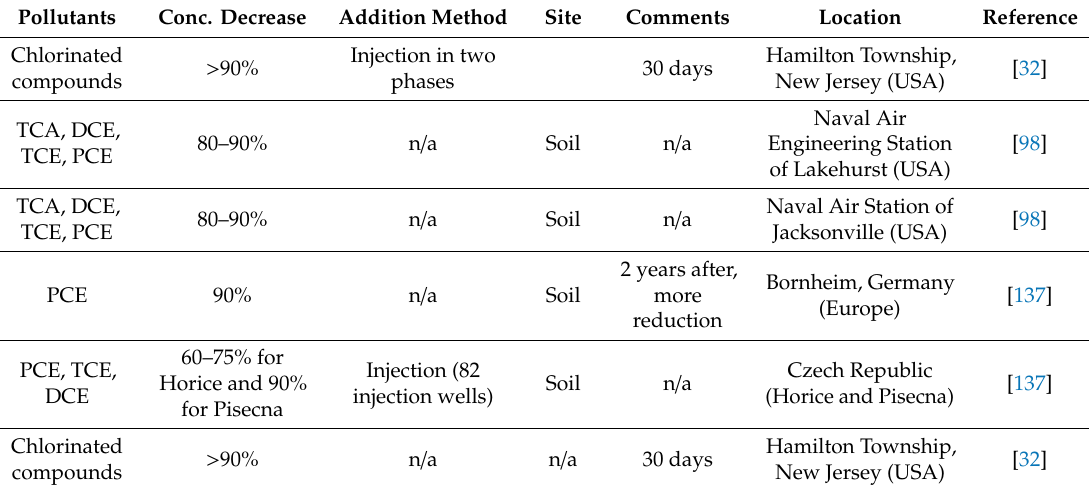
Table 6. Summary of pilot and full-scale tests for polymer coated NZVI